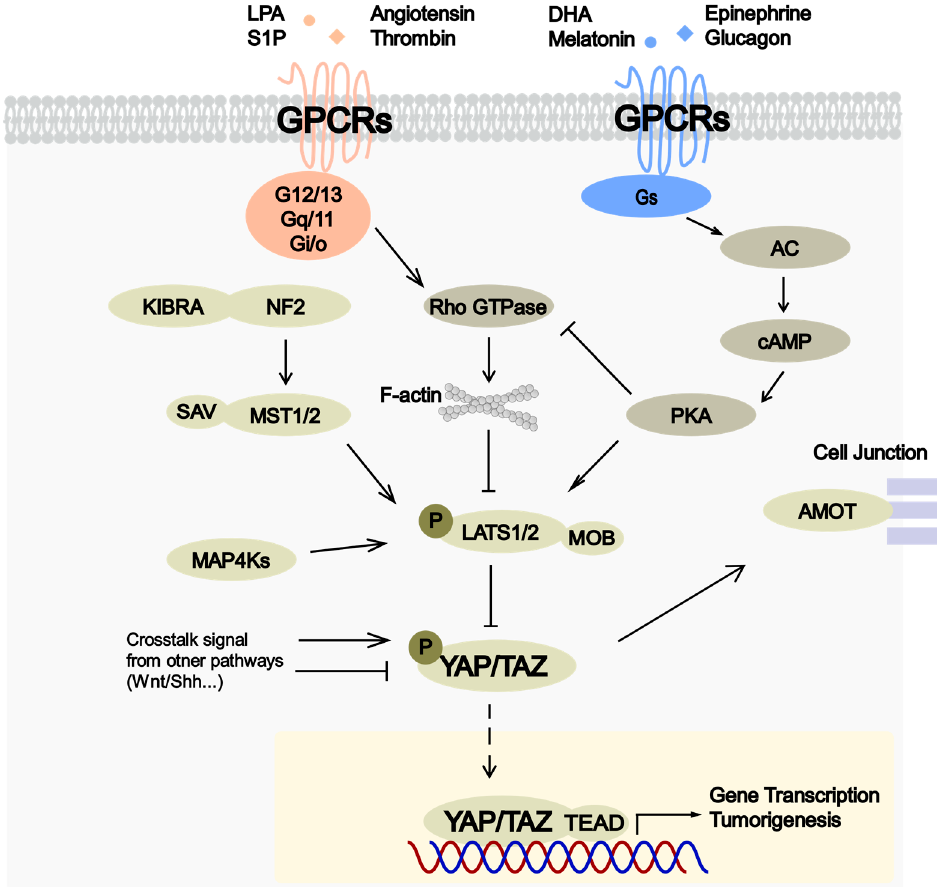
Figure 1. GPCRs modulate Hippo-YAP signaling via GPCRs–G-protein–cytoskeleton axis. The molecular scheme of GPCR-Hippo signaling is shown, including activating and inhibitory regulation of YAP/TAZ. GPCRs and G proteins activating YAP/TAZ are marked with red and those inhibiting YAP/TAZ are in blue.